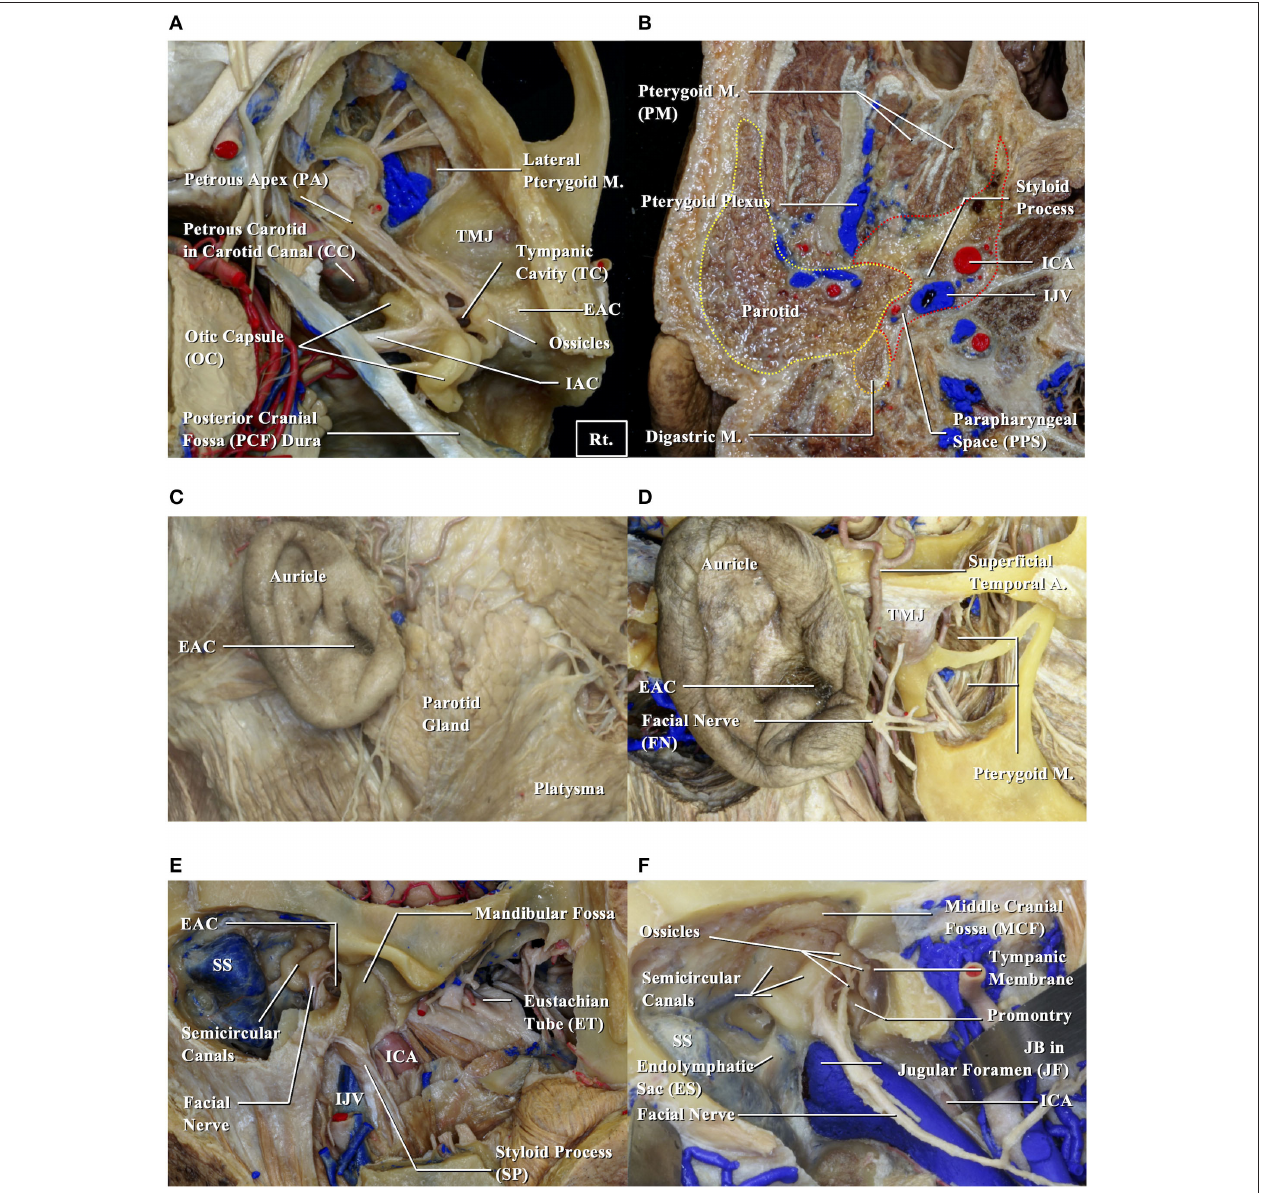
FIGURE 1 | Anatomical structures related to EAC squamous cell carcinomas. EAC, external auditory canal; ICA, internal carotid artery; IJV, internal jugular vein; JB, jugular bulb; M, muscle; SS, sigmoid sinus; TMJ, temporomandibular joint. (A,B) Cadavers are dissected from above (A) and below (B) . (C) Structures around the auricle are exposed. (D) Structures around the temporomandibular joint are exposed. (E) Structures related to the bony part of EAC are exposed. (F) Relationship between the middle ear and surrounding structures is shown.